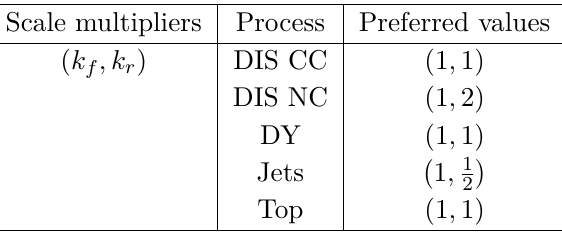
Table 2 . The preferred scale combination for each process, calculated from the distributions given in figure